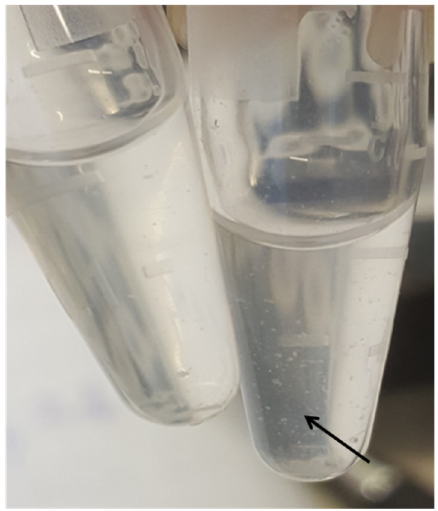
Figure 1. Determination of hyaluronidase activity: on the left—control, on the right—the arrow shows clots, indicating a positive reaction.